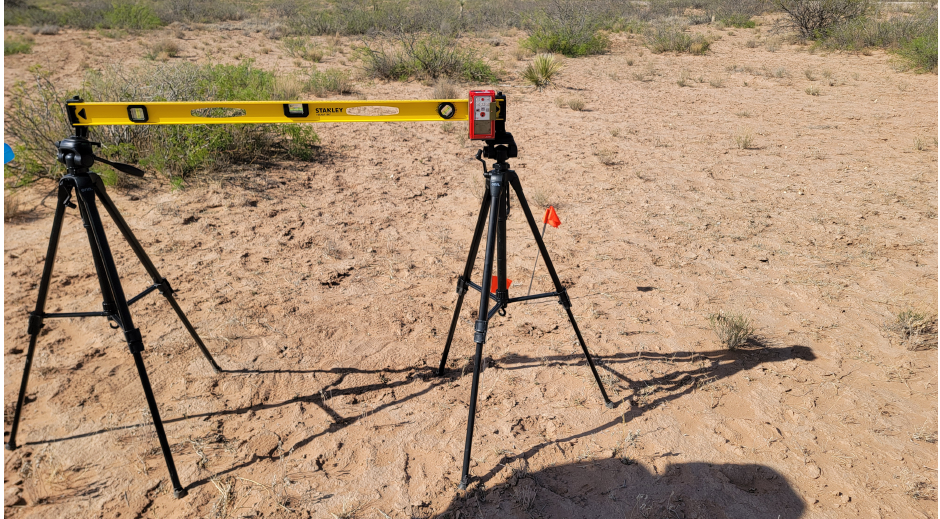
Figure 4. Photo of the surface roughness measurement